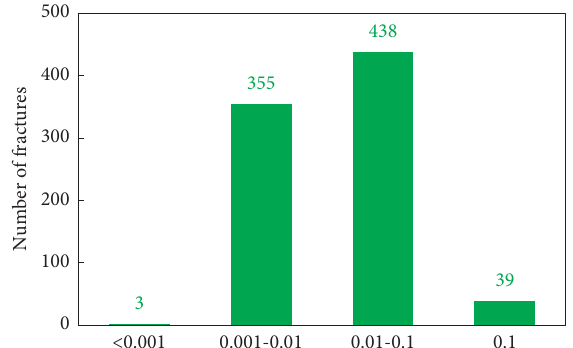
Figure 3: Numbers of the fractures with different opening